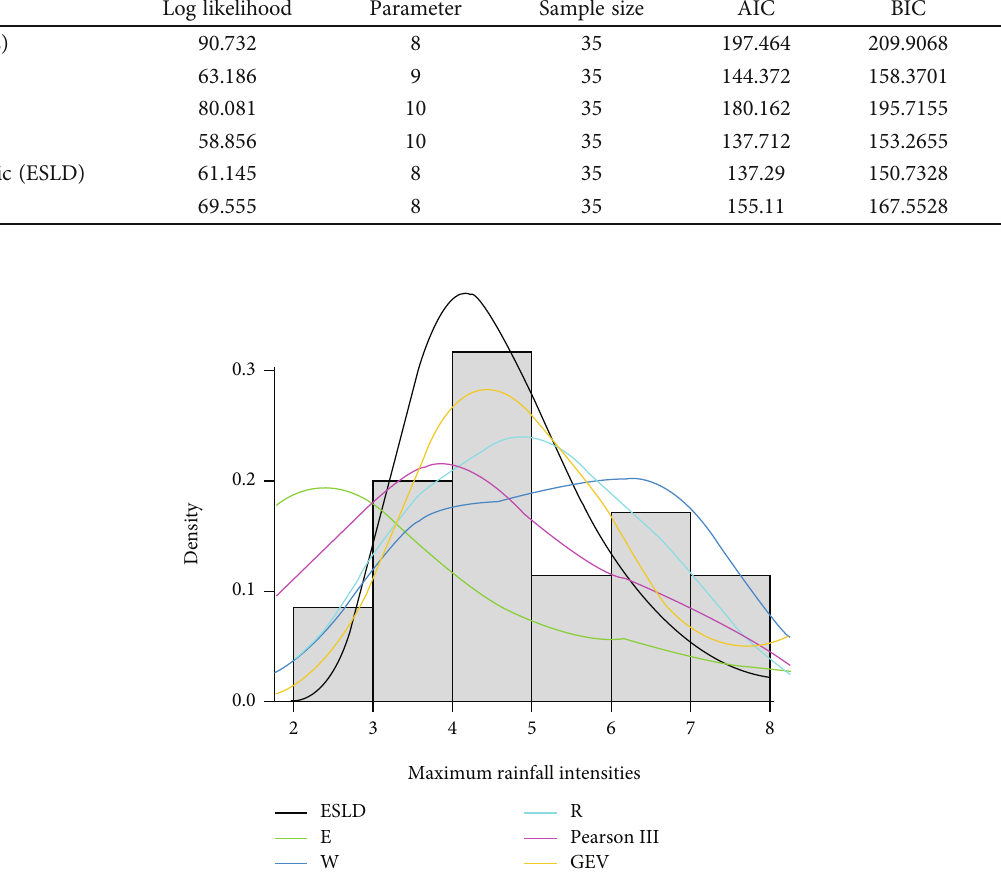
Figure 11: Plot of rainfall intensities with the fi tted distributions. Table 5: Factors coe ffi cients and p values for ESLD.